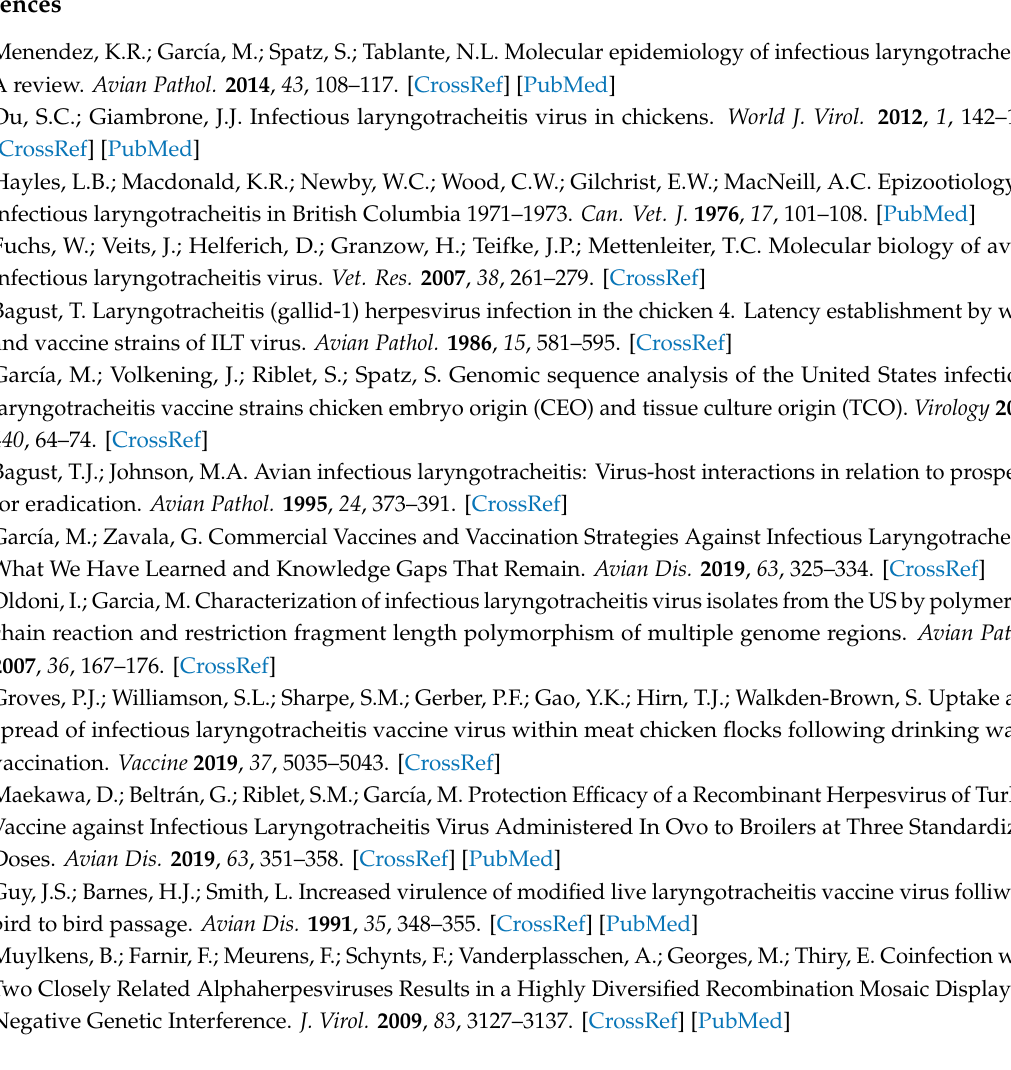
Table S1. Depth variation along the genome of the 14 ILTV Canadian sequences, Table S2. The representative ILTV whole genome sequences ( n = 36) that were obtained from public domain and their genome length and Genbank accession numbers for the purpose of aligning with the Canadian ILTV whole genome sequences, Table S3. Clinicopathological history of the ILTV infected chickens where the 14 Canadian ILTV samples that yielded full genome sequences originated, Table S4. Proposed genotype for the 14 Canadian ILTV sequences adressed in this study, and average percent identity with the rest of the sequences belonging in the corresponding